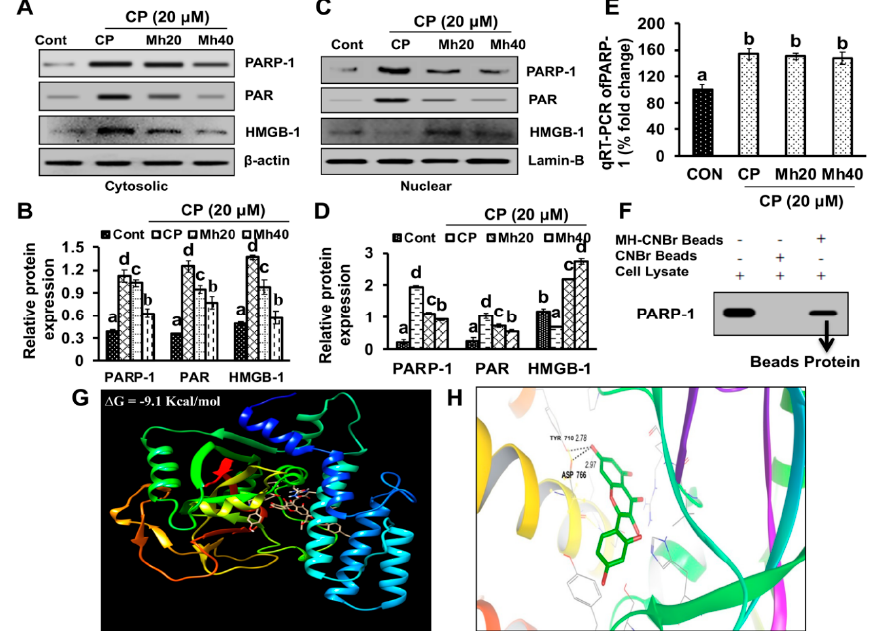
Figure 5. Regulatory effect of CP and CP-Mh on PARP-1-HMGB1 signaling. ( A ) The cytoplasmic expression of PARP-1, PAR and HMGB1 determined by Western blot analysis using specific antibodies after corresponding drugs treatment in HepG2 cells. Results are normalized to β -actin in respective controls. ( B ) Relative expression was calculated by densitometry analysis using the ImageJ software. ( C ) Nuclear expression of PARP-1, PAR and HMGB1 was analyzed using specific antibodies after corresponding drugs treatment in HepG2 cells. Results are normalized to Lamin B in respective controls. ( D ) Relative expression was measured by densitometry analysis using the ImageJ software. ( E ) Quantitation of PARP-1 mRNA level by qRT-PCR after corresponding drug treatment in HepG2 cells. The data are represented as the means standard deviation ( ± SD, n = 3). The values of di ff erent letters (a–d) di ff er significantly from each other ( p < 0.05). ( F ) Binding of MH with PARP-1 in HepG2 cells detected by pull-down assay following Western blot analysis. ( G ) The interaction between MH and PARP-1 is shown in the docked complex; Mh is shown as stick model and PARP-1 is represented as ribbon model. ( H ) Hydrogen bonding and hydrophobic interaction between MH and PARP-1 calculated by shape complementary based